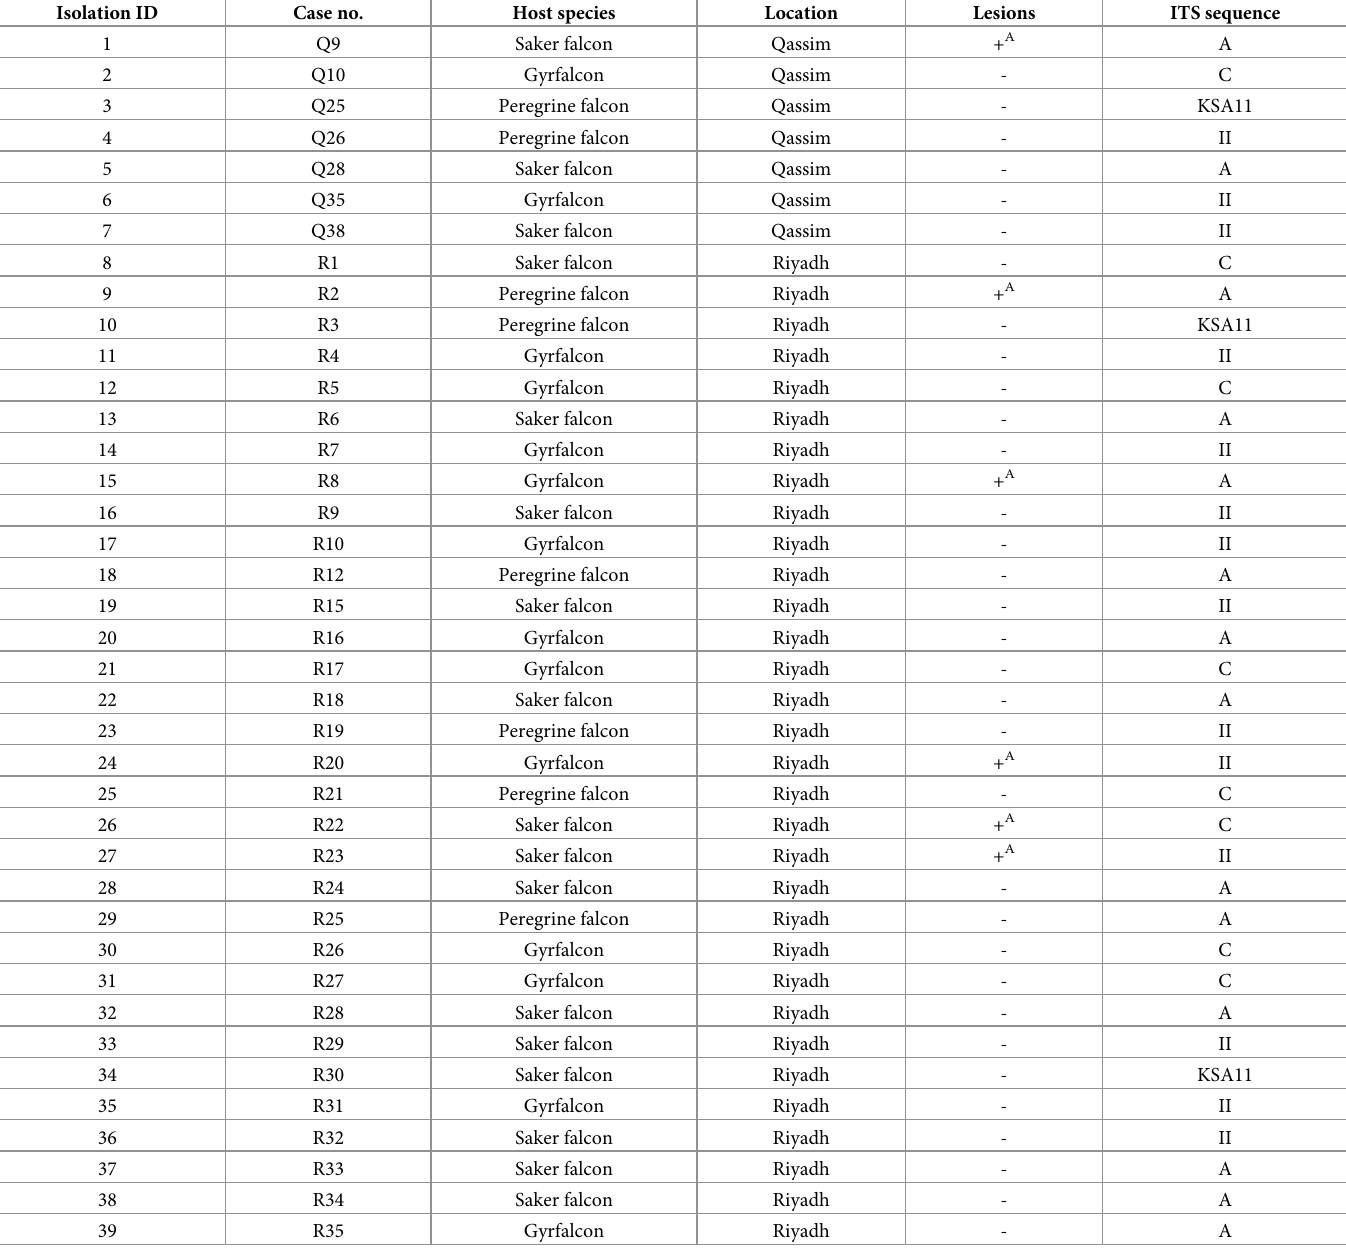
Table 2. Sample details of captive falcons. List of species, geographical location, evidence of lesions, and ITS sequence of Trichomonas gallinae . All samples were obtained from adult birds, collected from Qassim and Riyadh region in Saudi Arabia. Isolation ID Case